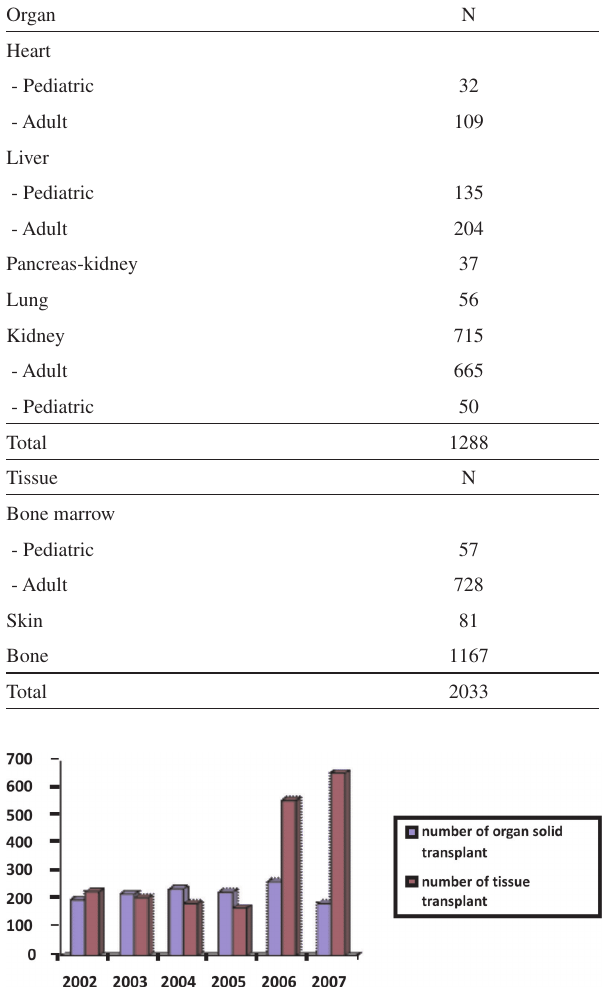
Table 1 - Number of transplant recipients at Hospital